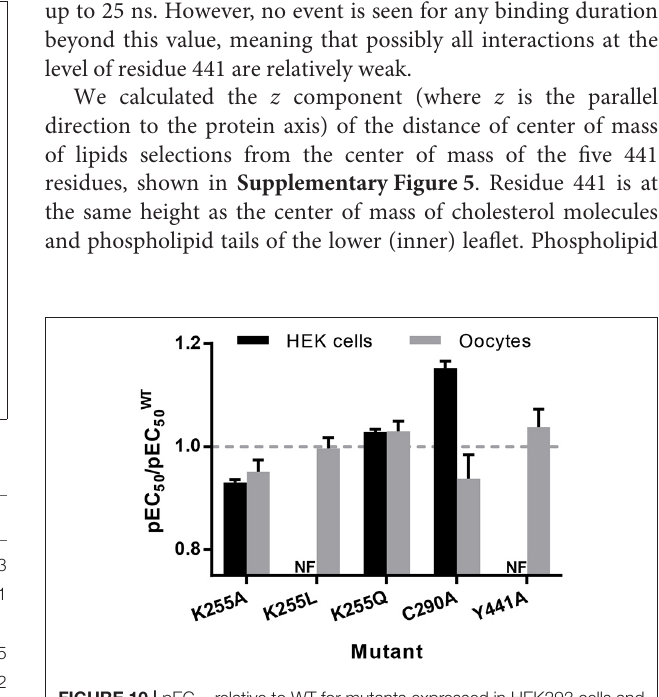
FIGURE 10 | pEC 50 relative to WT for mutants expressed in HEK293 cells and Xenopus oocytes, from Tables 1 – 3 . Data is mean ± SEM, n ≥ 3; values less than 1 indicate loss-of-function, and values greater than 1 indicate